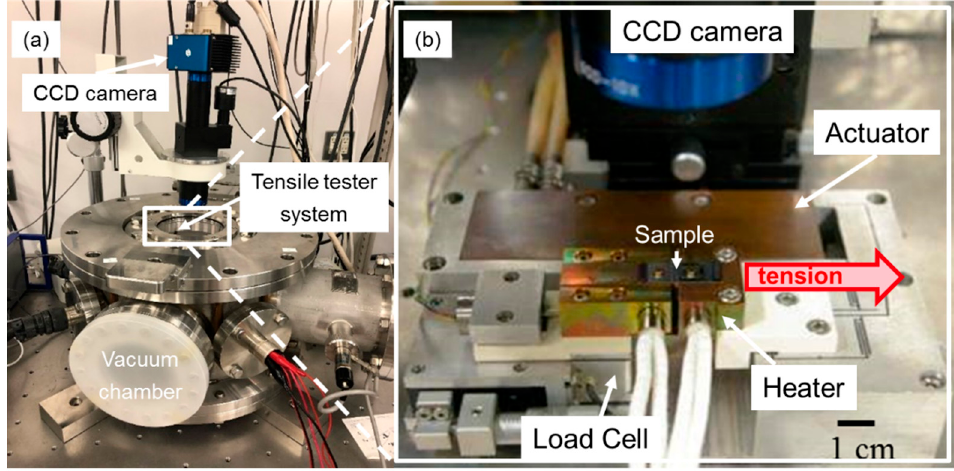
Figure 2. Tensile tester system ( a ): overall equipment image ( b ): magnified tensile tester system.